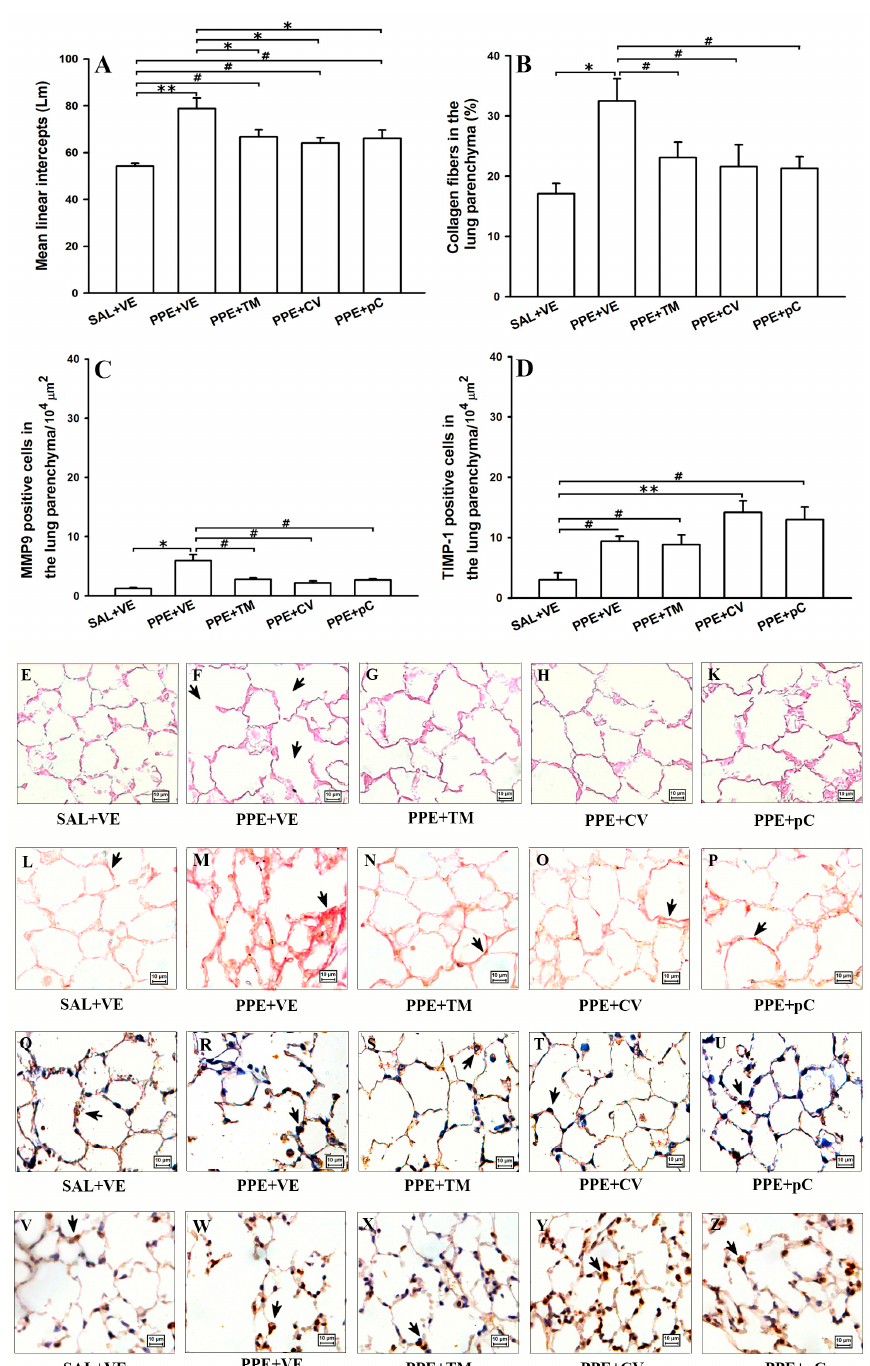
Figure 4. Effects of monoterpenes thymol, carvacrol and p -cymene on alveolar septa. Data are presented as mean ± standard error (SE) ( n = 5 mice/group) of: mean linear intercepts (Lm) ( A ); volume proportion of collagen fibers ( B ); and the number of positive cells to MMP-9 ( C ); and TIMP-1 ( D ) in lung of mice in the 28th day of the protocol. The photomicrographs represent the lung tissue of one animal from control ( E , L , Q , V ), PPE treated with vehicle ( F , M , R , W ) and PPE treated with thymol ( G , N , S , X ), carvacrol ( H , O , T , Y ) or p -cymene group ( K , P , U , Z ) stained with HE (first line), picro-sirius to detect collagen fibers (second line), by immunohistochemistry to MMP-9 and TIMP-1 (third and fourth line respectively). Arrows indicate lung emphysema, collagen deposition and positive cells. SAL + VE: control group with vehicle treatment; PPE + VE: porcine pancreatic elastase instillation and vehicle treatment; PPE + TM: porcine pancreatic elastase instillation and thymol treatment; PPE + CV: porcine pancreatic elastase instillation and carvacrol treatment; PPE + pC: porcine pancreatic elastase instillation and p -cymene treatment. * p < 0.01, ** p < 0.001 and # p < 0.05.